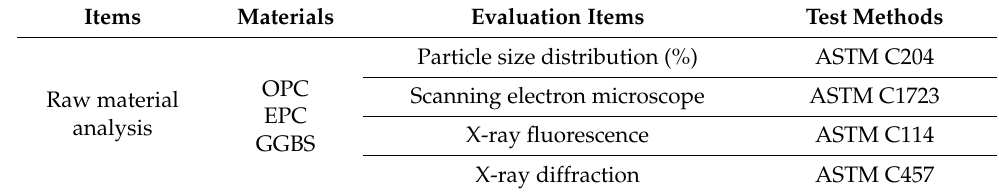
Table 5. Test methods for raw materials of binders.